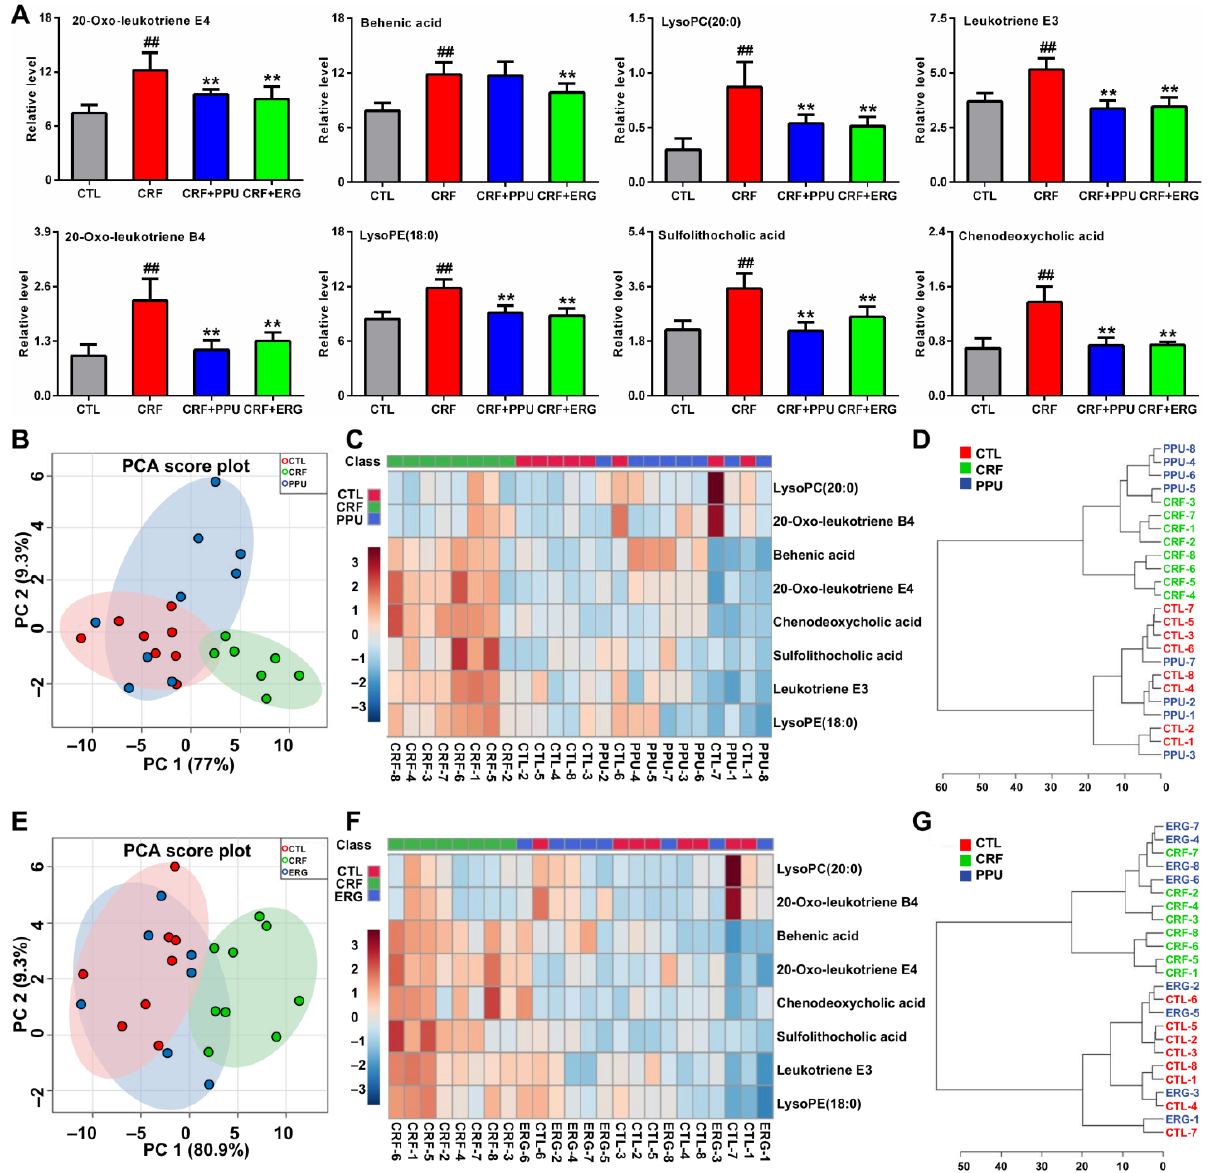
Figure 6. The dysregulation of eicosanoids and bile acids were restored by treatment of PPU and ERG. ( A ) Comparison of the relative intensities of eight lipid species in serum of control, CRF, CRF+PPU, and CRF+ERG rats. ( B ) PCA of two components of eight lipid species from control, CRF, and CRF+PPU rats. ( C ) Heatmap clustering analysis of eight lipid species in serum of control, CRF, and CRF+PPU rats. ( D ) Dendrogram of hierarchical clustering analysis based on eight lipid species in serum of control, CRF, and CRF+PPU rats. ( E ) PCA scores plot of eight lipid species from control, CRF, and CRF+ERG rats. ( F ) Heatmap clustering analysis of eight lipid species in serum of control, CRF, and CRF+ERG rats. ( G ) Dendrogram of hierarchical clustering analysis based on eight lipid species in serum of control, CRF, and CRF+ERG rats. ## — p < 0.01 compared with CTL rats; **— p < 0.01 compared with CRF